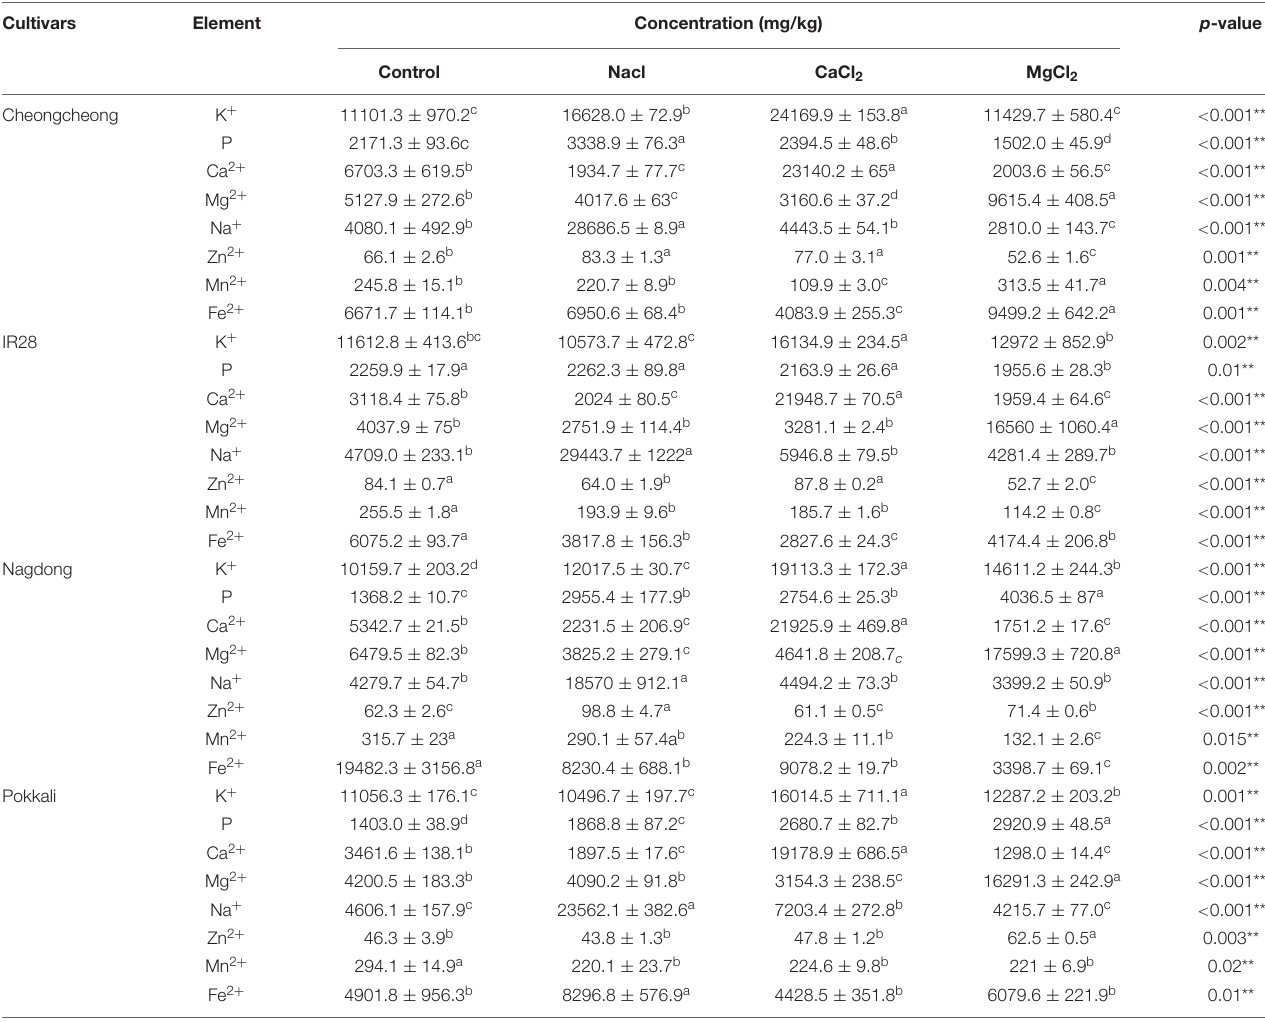
TABLE 2 | Effects of different salt stress on nutrients uptake in soil among rice cultivar roots. Cultivars